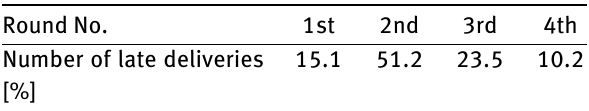
Table 1: Percentage share of late deliveries by individual delivery